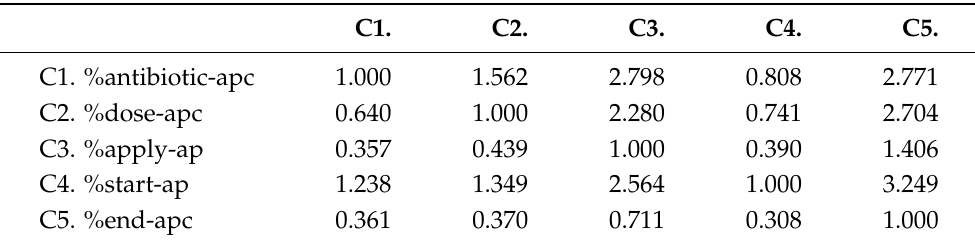
Table 10. Group pairwise comparison matrix for the antimicrobial prophylaxis in colorectal surgery